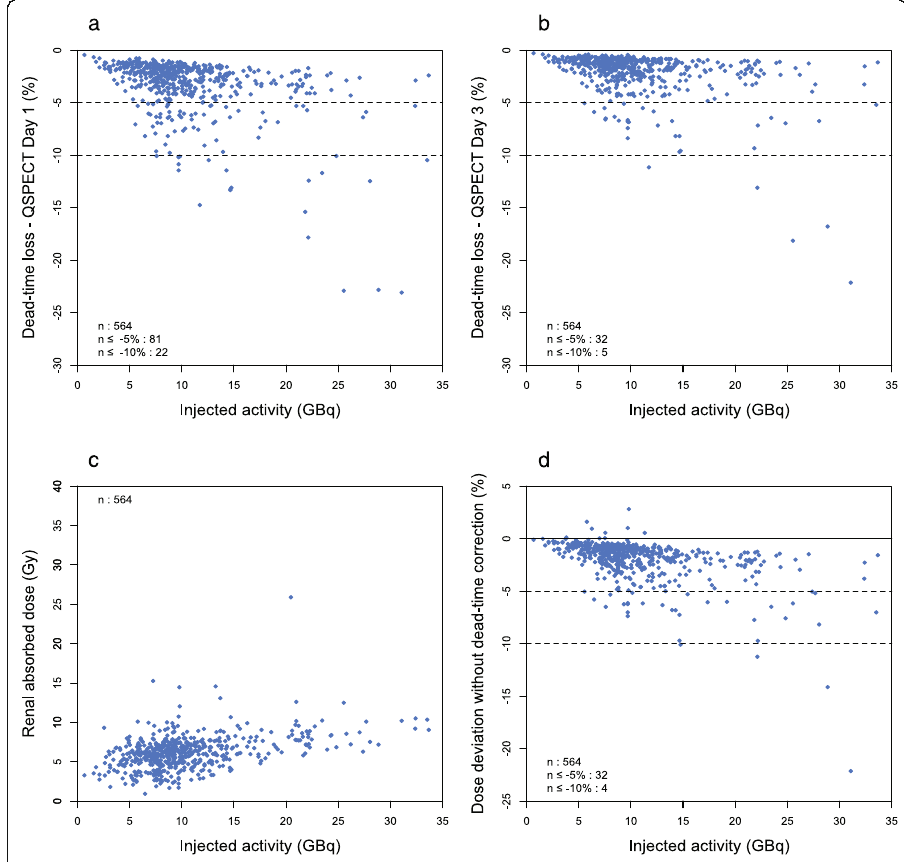
Fig. 1 Dead time and renal dosimetry in personalized PRRT. The dead-time count loss affecting day 1 ( a ) and day 3 ( b ) QSPECT scans, the renal absorbed dose ( c ) and its deviation without dead-time correction ( d ) are plotted against the injected